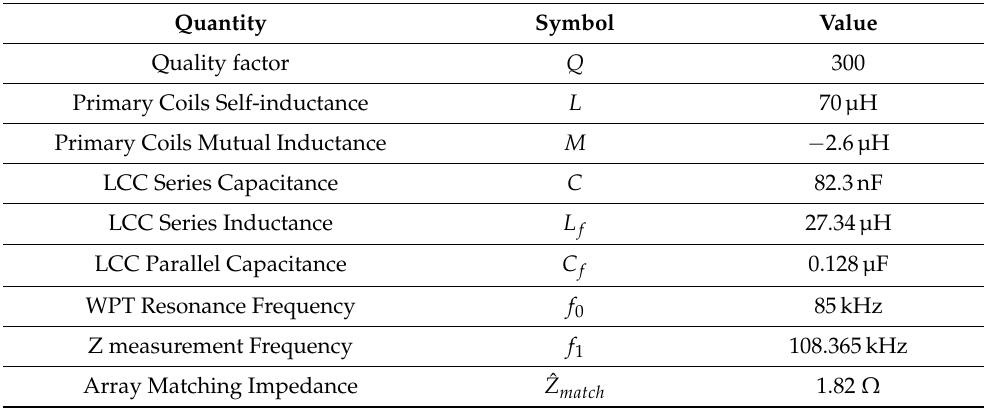
Figure 3. ( a ) Magnitude and ( b ) phase of the driver coil impedance ˆ Z as a function of the frequency. Table 1. Resonator Array